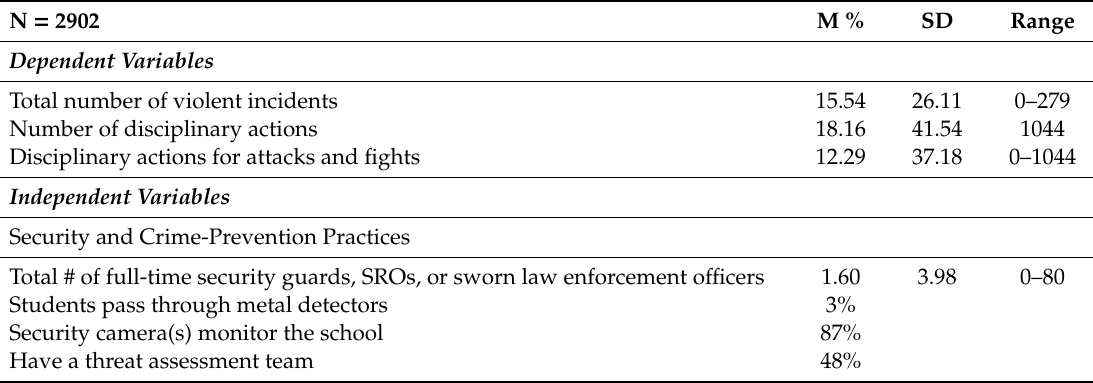
Table 1. Summary of data and independent and dependent variables for reducing school